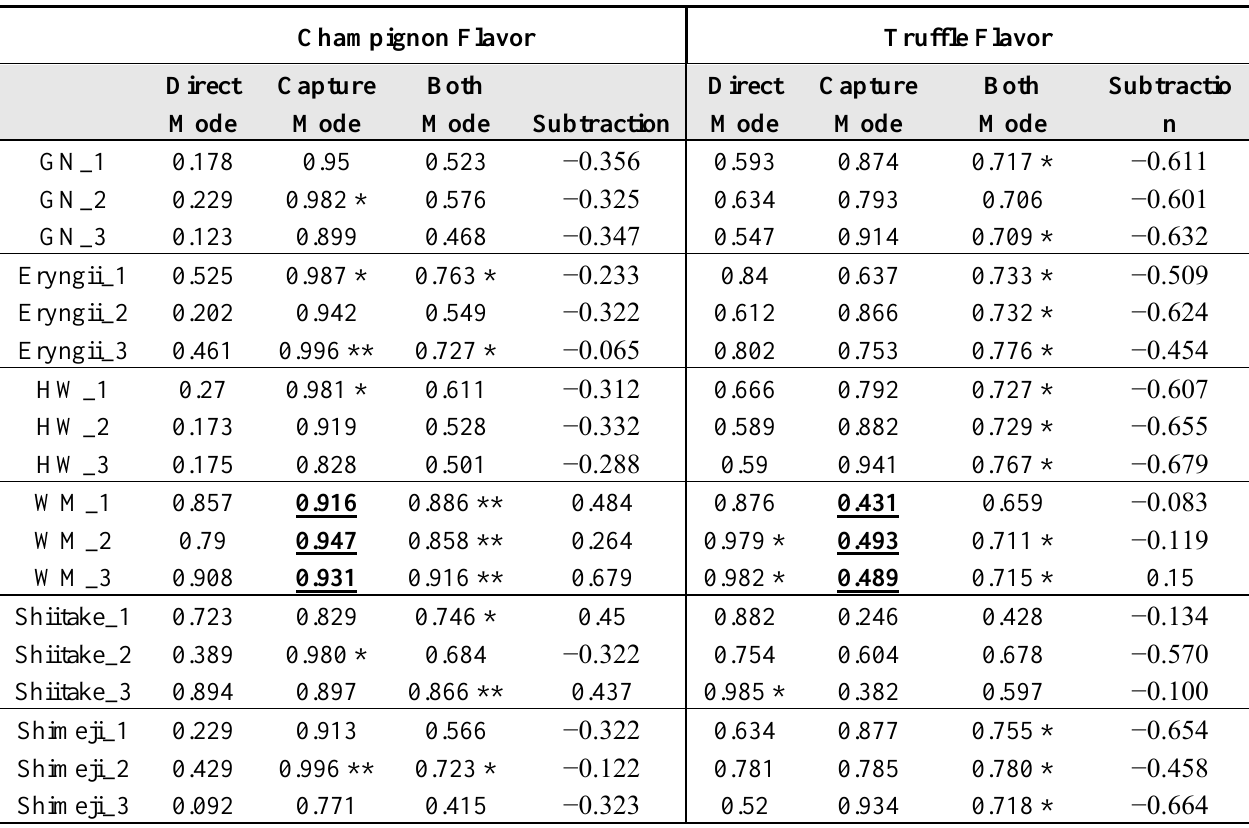
Table 5. Correlation Coefficient ( r ) between Mushrooms‘ Smells and Mushroom-like Flavors using Standardized Sensors‘ Values of